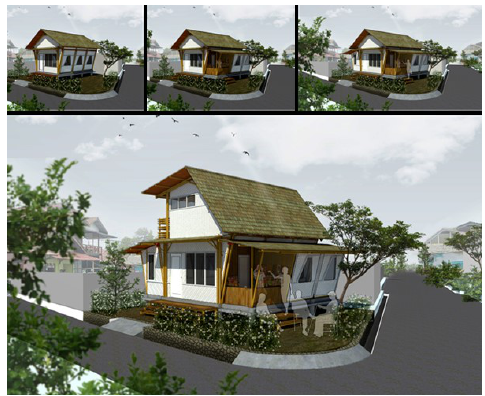
Fig. 14. Bamboo Incremental House Design Concept Visual-